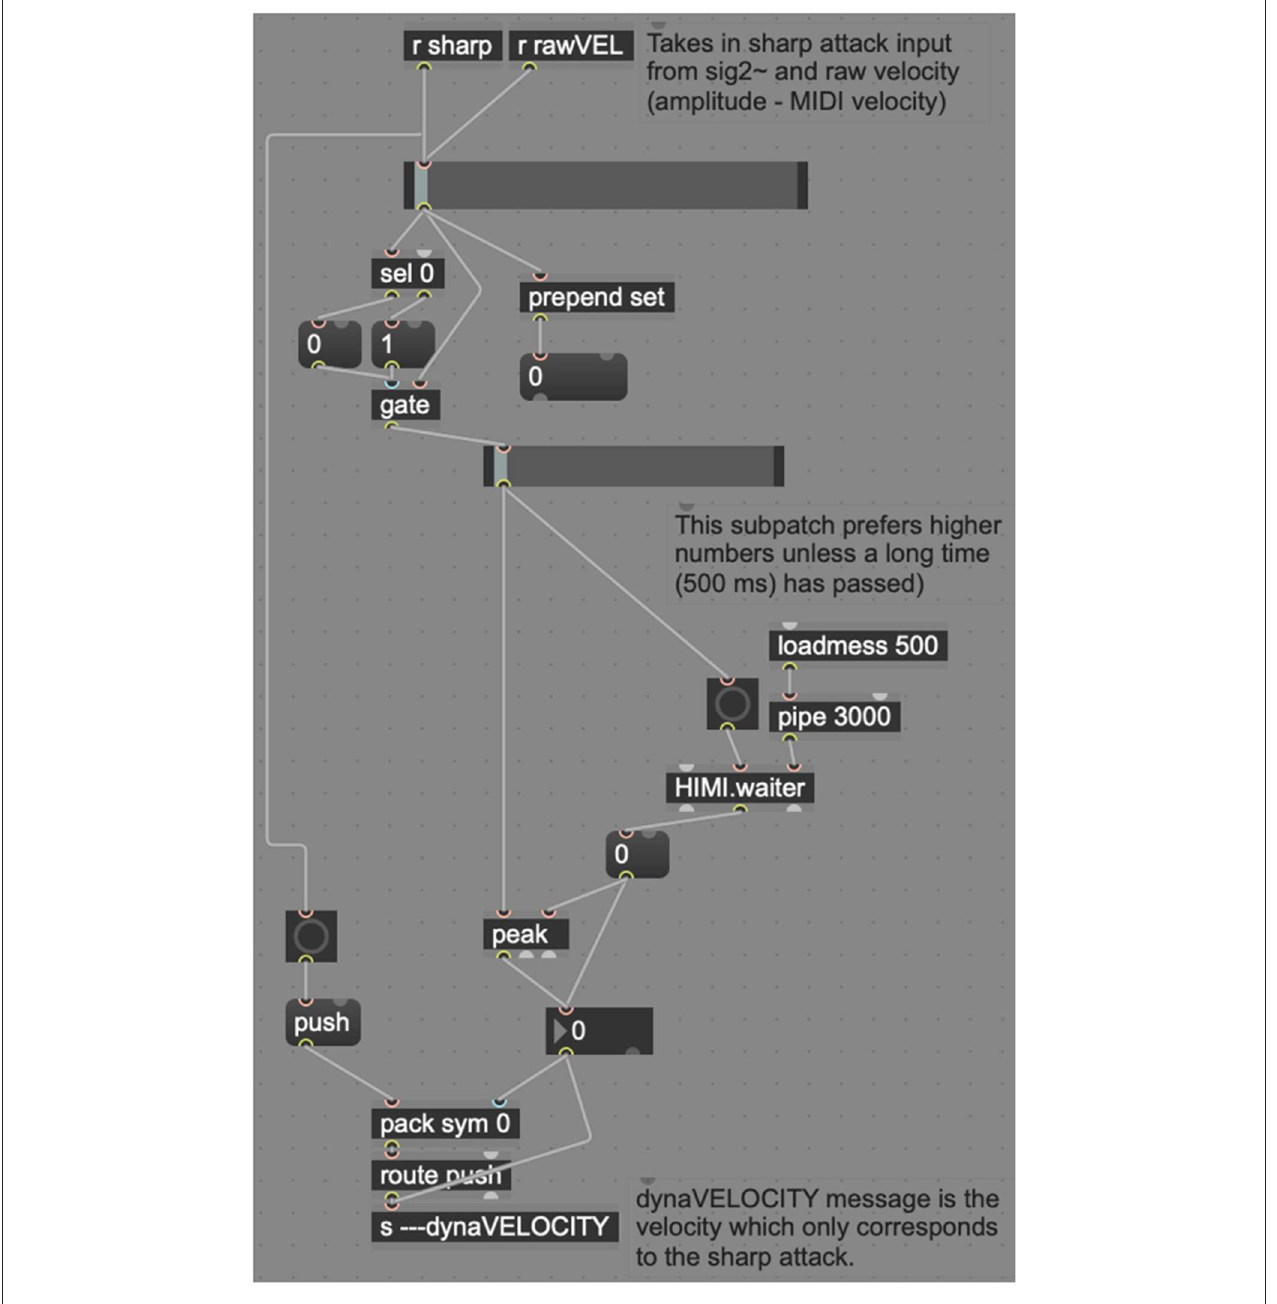
FIGURE 9 | Dyna’s sharpvelocitycalculation